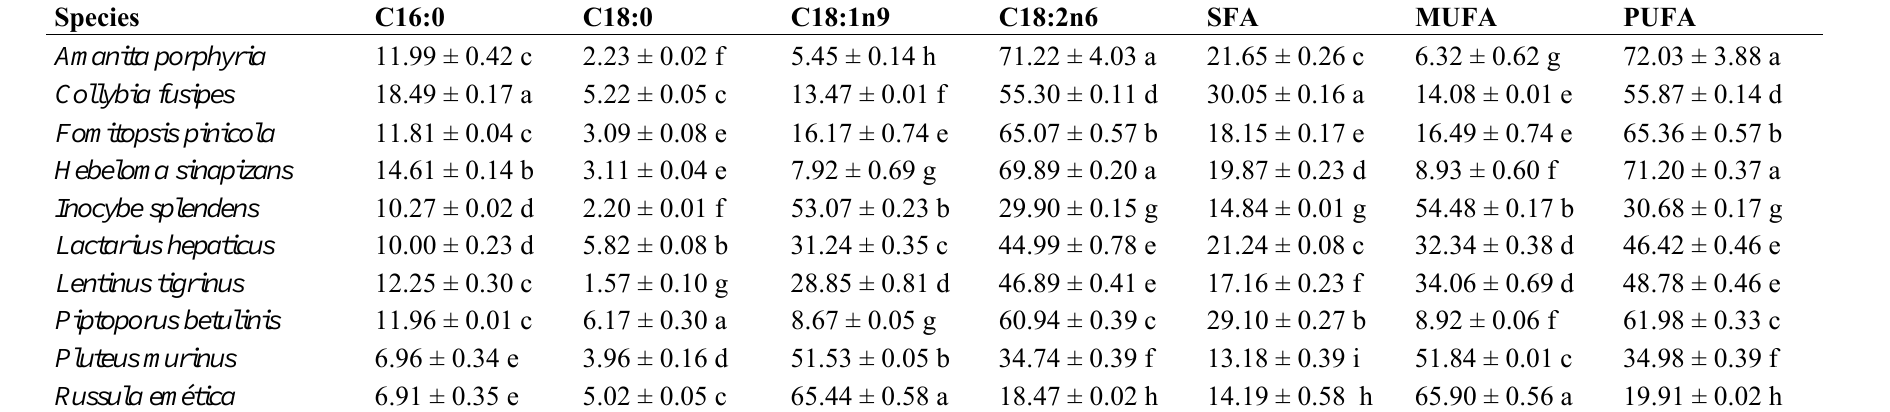
Table 2. Biomolecules (fatty acids) with energetic value.